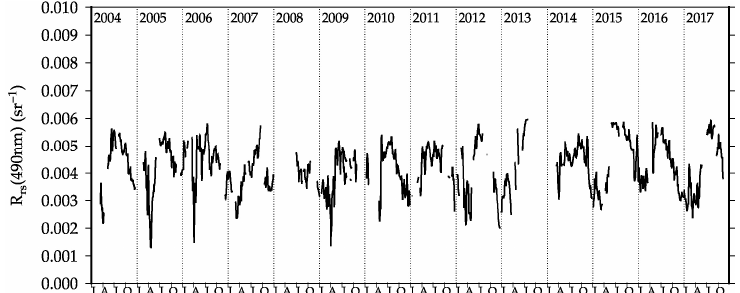
Figure 7. 2004–2017 time series of the remote sensing reflectance at 443 nm at BOUSSOLE.